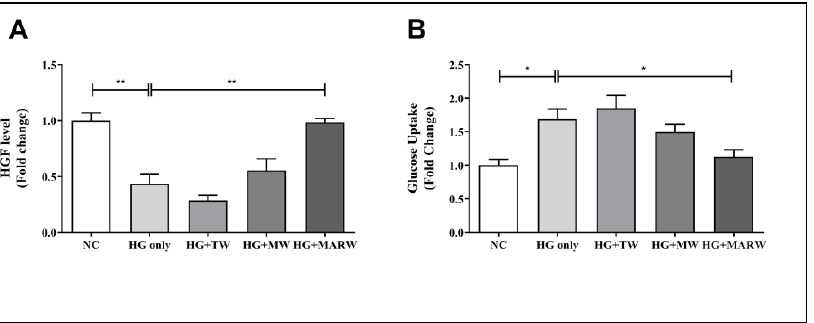
Figure 3. Effects of HG on TW, MW and MARW in HGF and glucose uptake levels in HK-2 cells with different concentrations. HK-2 cells were induced with glucose (71.68 mM) for 24 h. After treatment, the ( A ) HGF and ( B ) glucose uptake levels were analyzed. * p < 0.05, and ** p < 0.01 represent significant differences based on Tukey’s ANOVA test. Values represent the mean ± SEM. Abbreviations: NC, normal control; HG, high glucose; TW, tap water; MW, mineral water; MARW, magnesium-enhanced alkaline-reduced water; HGF, hepatocyte growth factor.